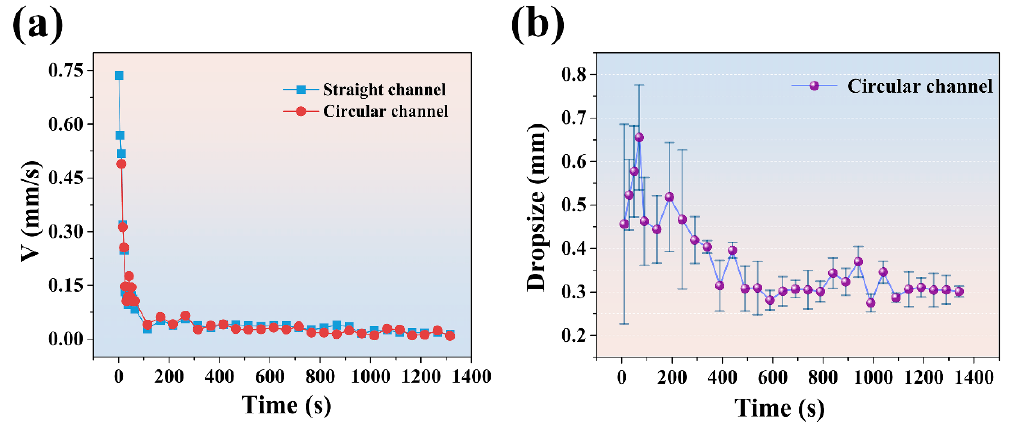
Figure 6. ( a ) The speed of dielectric droplets in the circular channel and straight channel ( b ) The size of dielectric droplets in the circular channel.